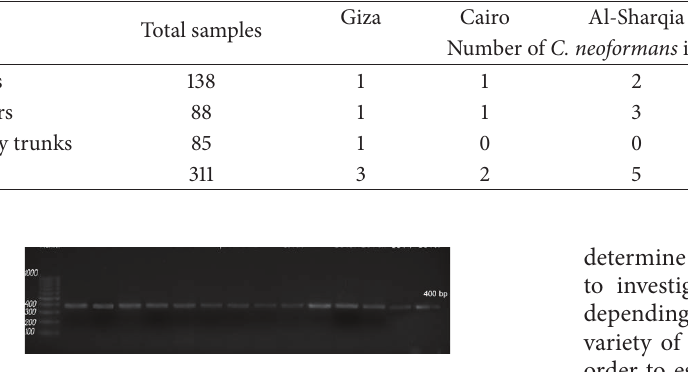
Figure 2: Agarose gel electropheresis of CAP64 gene specific PCR of all the examined C. neoformans isolates with production of amplicons of 400 bp, marker 100bp DNA ladder (Jena Bioscience).